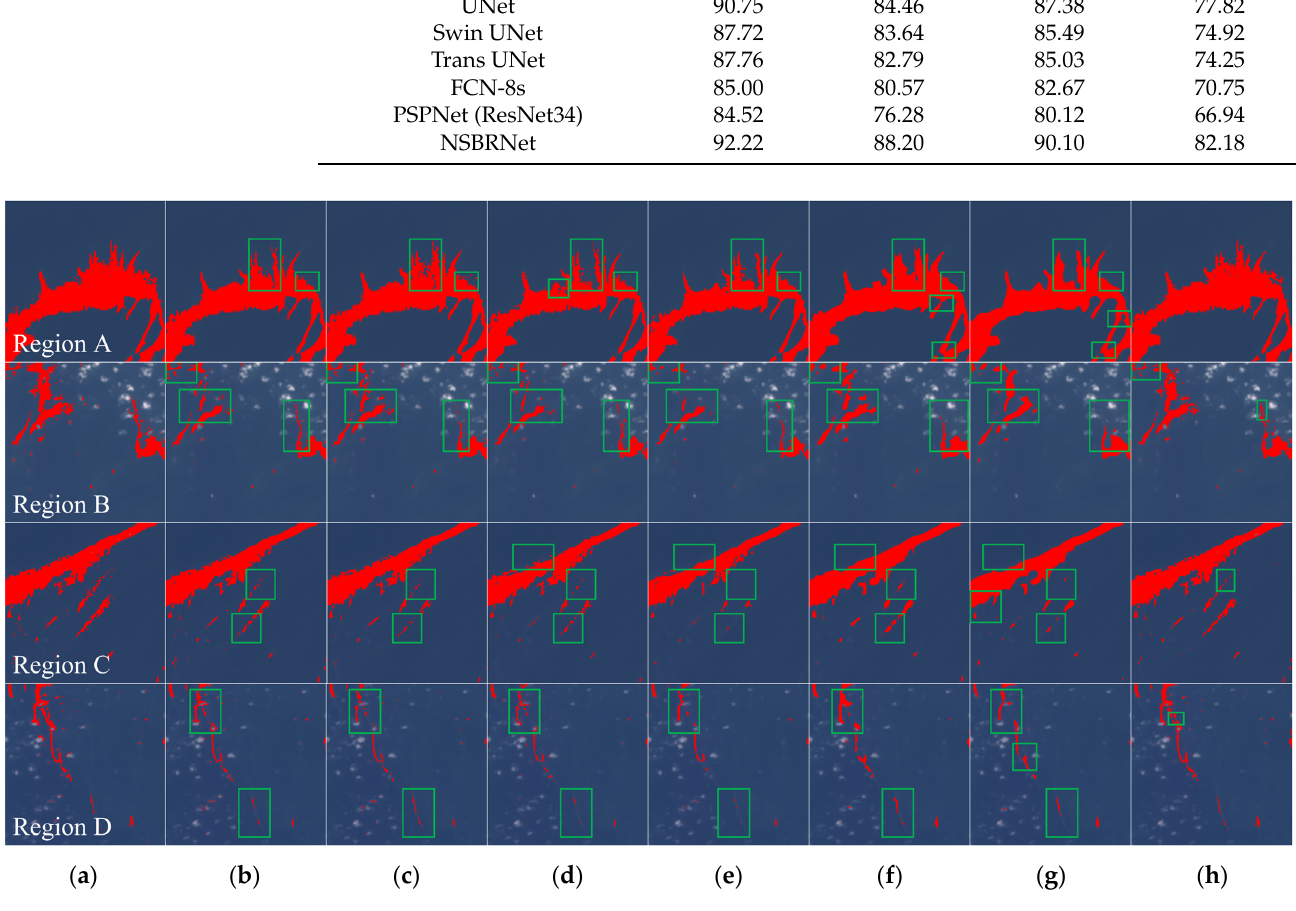
Figure 12. CZI NSB recognition result. ( a ) Ground truth; ( b ) Res UNet; ( c ) UNet; ( d ) Swin UNet; ( e ) Trans UNet; ( f ) FCN-8s; ( g ) PSPNet; ( h ) NSBRNet.